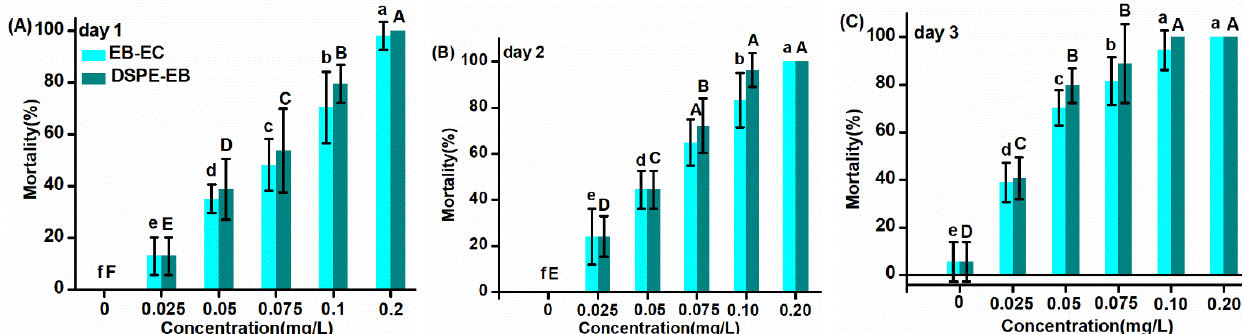
Figure 6. Mortality of different concentrations of EB-EC and DSPE-EB against third-instar S. furgiperda larvae at 1 (A ), 2 ( B ) and 3 d ( C ) after treatment. Data with different lowercase letters (EB-EC) and uppercase letters (DSPE-EB) are significantly different at the p < 0.05 level according to Duncan’s multiple range test. In all the above data, the error bars represent the standard errors of the means of three replicates. Table 1. Indoor toxicity results of DSPE-EB nanoparticles and EB-EC against the third-instar S. furgi- perda larvae .